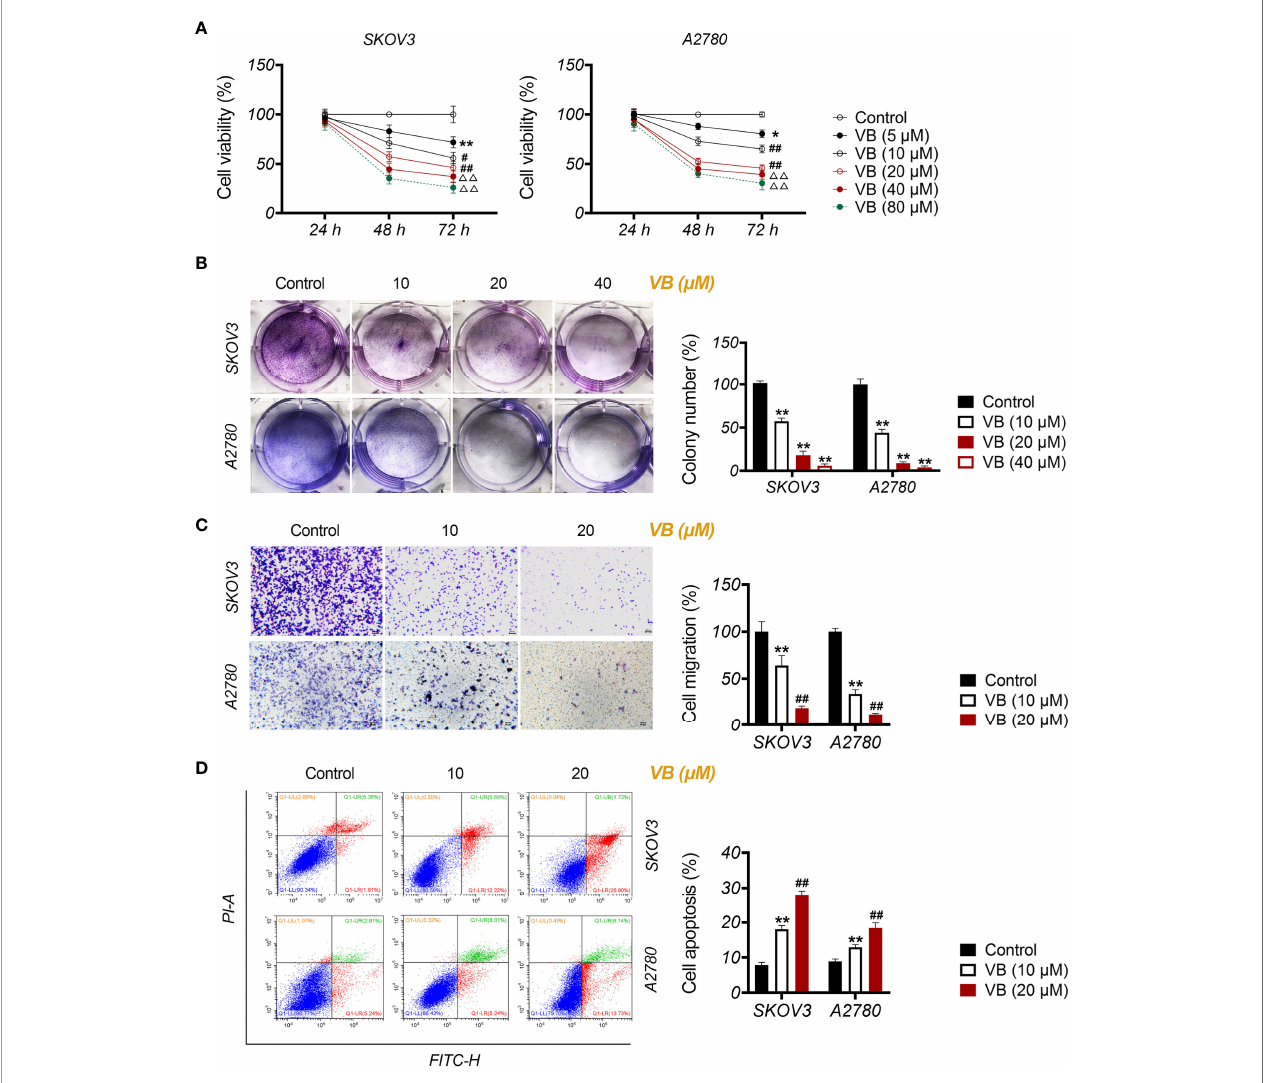
FIGURE 1 | Verbascoside (VB) inhibits proliferation and migration, and promotes apoptosis of ovarian cancer (OC) cells. (A) The viability of A2780 and SKOV3 cells was examined using the CCK8 assay. * P < 0.05 and ** P < 0.01 vs. the control; # P < 0.05 and ## P < 0.01 vs. the VB (5 µM) group; DD P < 0.001 vs. the VB (10 µM) group. (B) The proliferation of A2780 and SKOV3 cells was detected by colony formation assay. (C) The migration of A2780 and SKOV3 cells was measured by transwell assay. Scar bar = 50 µm. (D) The apoptosis of A2780 and SKOV3 cells was detected by fl ow cytometry. A2780 and SKOV3 cells were treated with different concentrations of VB (5 – 80 µM). Each treatment was thrice replicated. Error bars represent the mean ± standard deviation (SD); ** P < 0.01 vs. the control; ## P < 0.01 vs. the VB (10 µM)